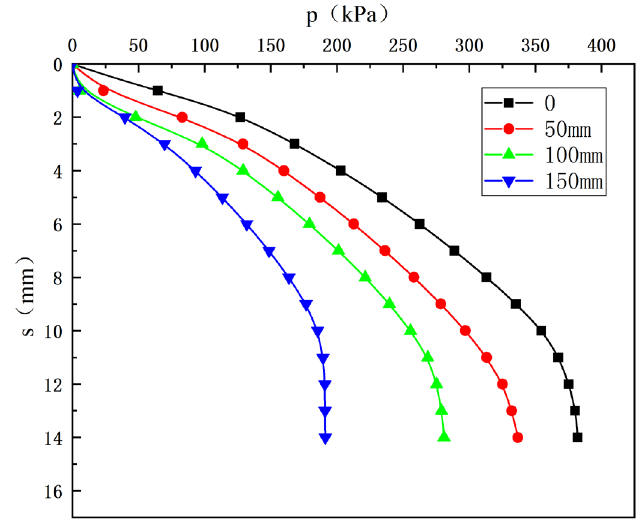
Figure 13. The p–s curves for different water-level heights.